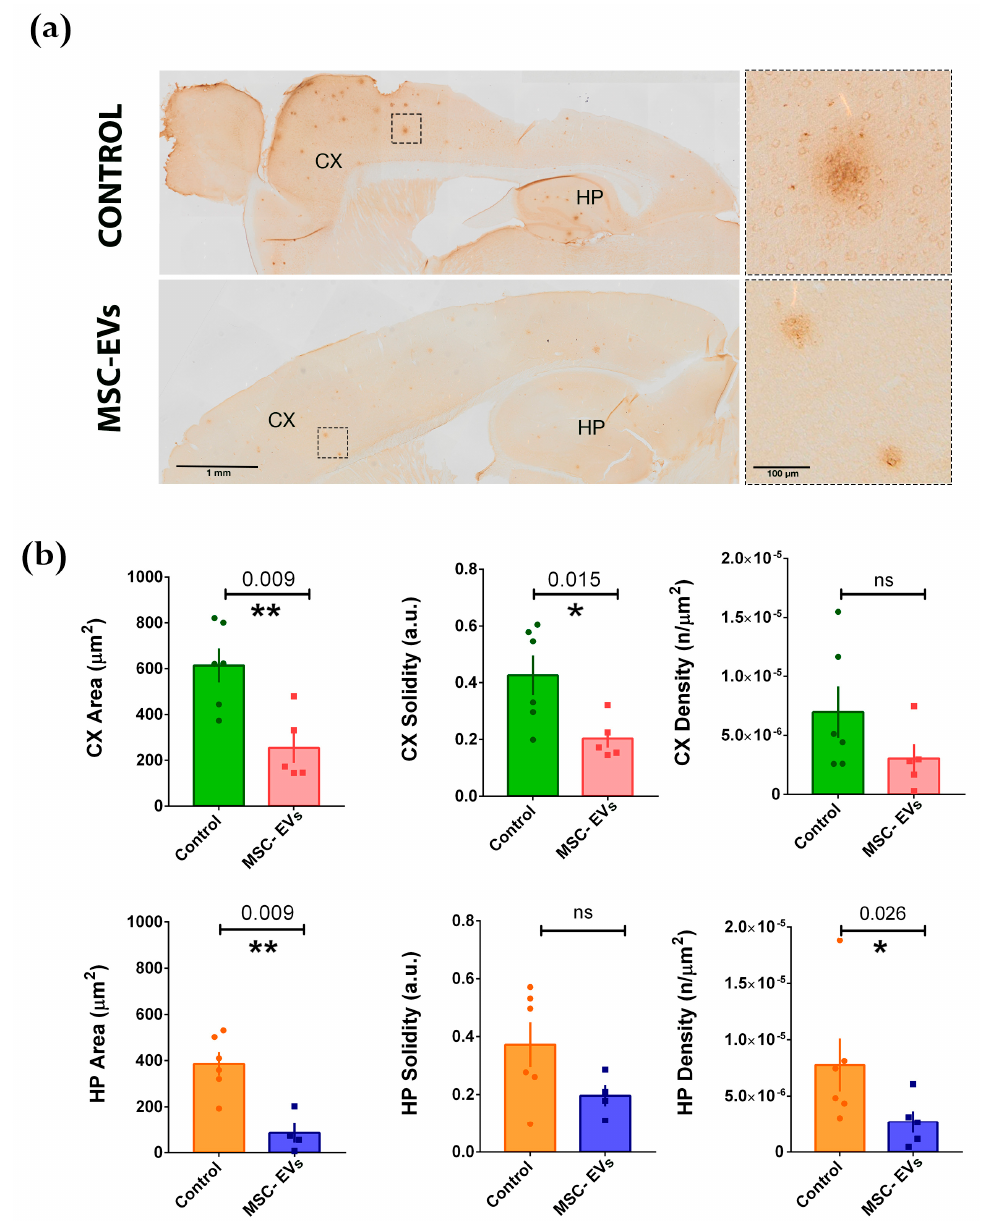
Figure 3. Intracerebral injection of BM-MSC-EVs (MSC-EVs) into 5-month-old APP / PS1 mice reduces amyloid deposition after ~1 month. ( a ) Immunohistochemical staining (DAB) of A β 1-42 plaques in brains of APP / PS1 mice treated with vehicle (CONTROL, top) or MSC-EVs (bottom). Scale bar: 1 mm. Panels on the right show higher magnification of representative plaques, contoured in the inset. Scale bar: 100 µ m. Cortex (CX) and Hippocampus (HP) are indicated. ( b ) Quantification of A β 1-42 positive plaques in the Cortex (CX; upper graphs: green and red histograms) and in the Hippocampus (HP; lower graphs: orange and blue histograms). Each dot represents an animal for which 10 slices have been scored. Statistical analysis was performed by non-parametric Mann-Withney test (* p < 0.05; ** p < 0.01).